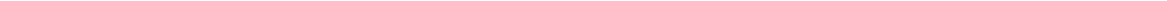
Fig. 5 RAR γ initiates the formation of death complexes by dissociating RIP1 from TNFR1. a Immunoprecipitation of HT-29 cont-shRNA, TRADD-shRNA or RIP1-shRNA treated with TSZ for the indicated times. Cell lysates were immunoprecipitated using anti-TNFR1 antibody and immunoblotted with the indicated antibodies. b Sequential immunoprecipitation of HEK293T cells co-transfected with FLAG-TNFR1, DsRed-RIP1 and increasing amounts of V5-RAR γ -NLSmut plasmids as indicated. First IP : cell lysates were immunoprecipitated with anti-FLAG (TNFR1) antibody. Second IP : the remaining lysates were then immunoprecipitated with anti-V5 (RAR γ ) antibody. The immunoprecipitated complexes were analyzed by with the indicated antibodies. c Sequential immunoprecipitation of HEK293T cells co-transfected with V5-RAR γ -NLSmut, RIP1-Myc, and increasing amounts of DsRed-RIP3 plasmids as indicated. First IP : cell lysates were immunoprecipitated with anti-V5 (RAR γ ) antibody. Second IP : the remaining lysates were then immunoprecipitated with anti-DsRed (RIP3) antibody. The immunoprecipitated complexes were analyzed with the indicated antibodies. d WT and RIP3 − / − MEFs treated with TSZ for the indicated times. Cell lysates were immunoprecipitated using anti-Caspase-8 antibody and immunoblotted with the indicated antibodies. All